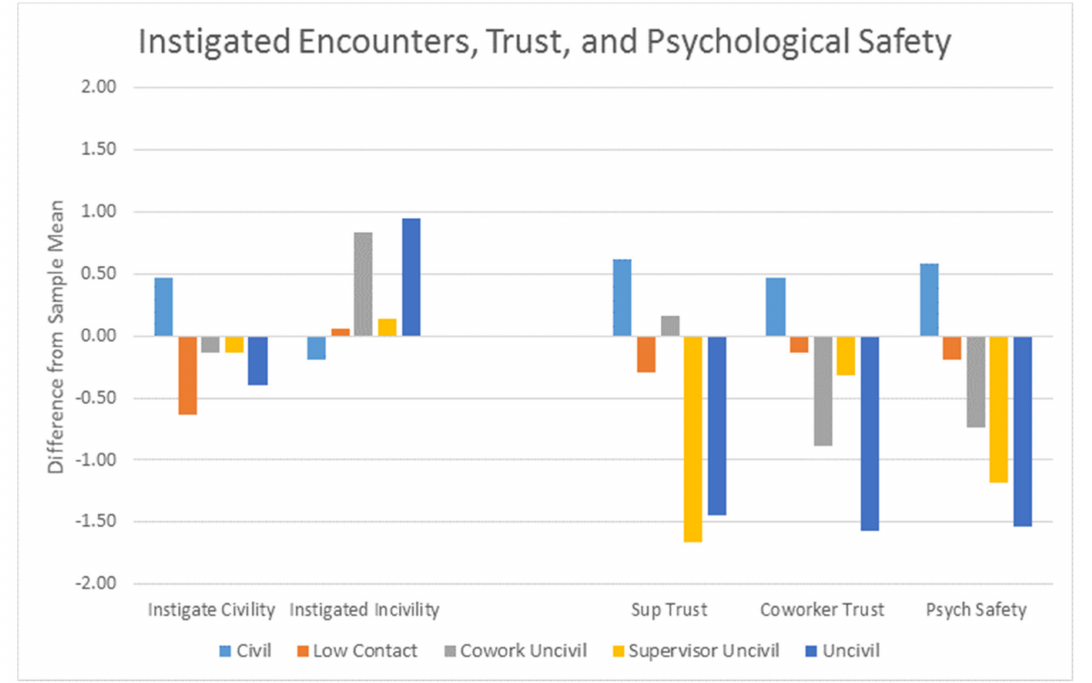
Figure 2. Instigated encounters, trust, and psychological